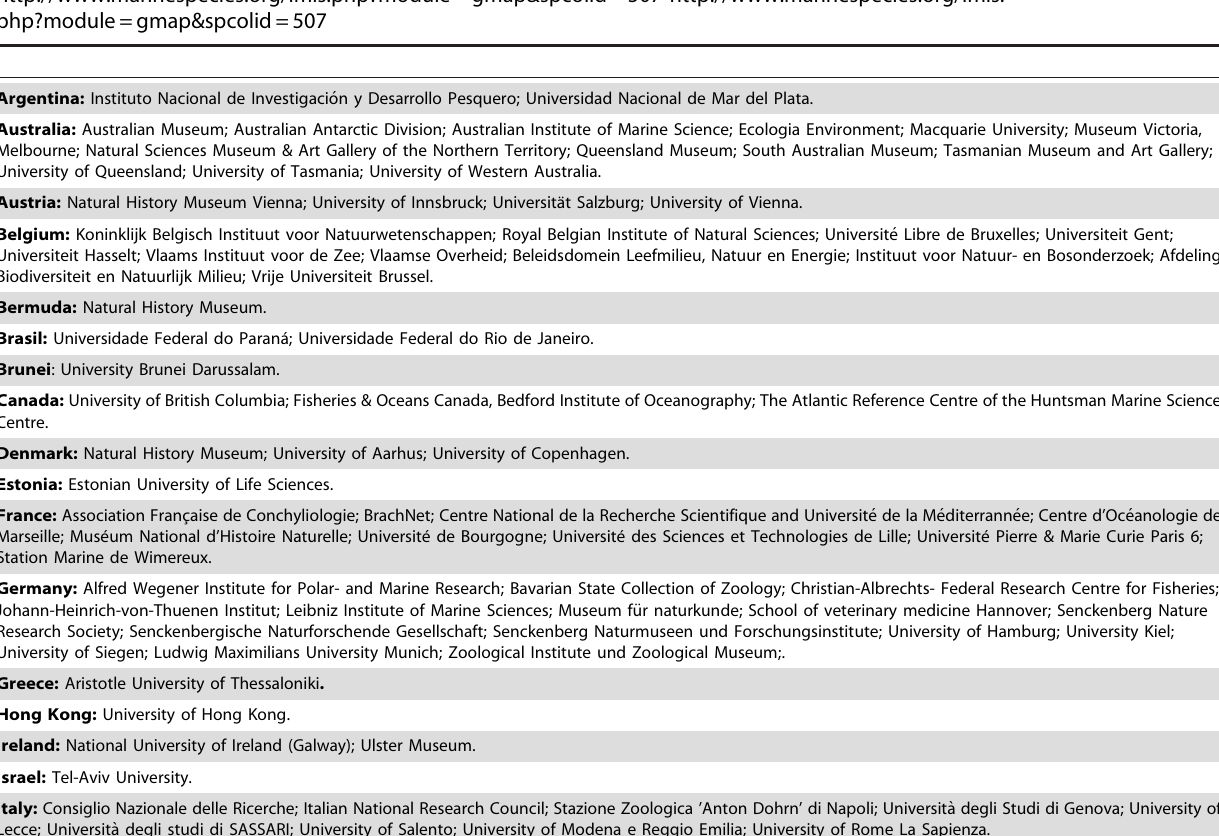
Table 4. The countries and institutes represented by the editors of WoRMS and its associated databases. These are mapped at http://www.marinespecies.org/imis.php?module =gmap&spcolid =507